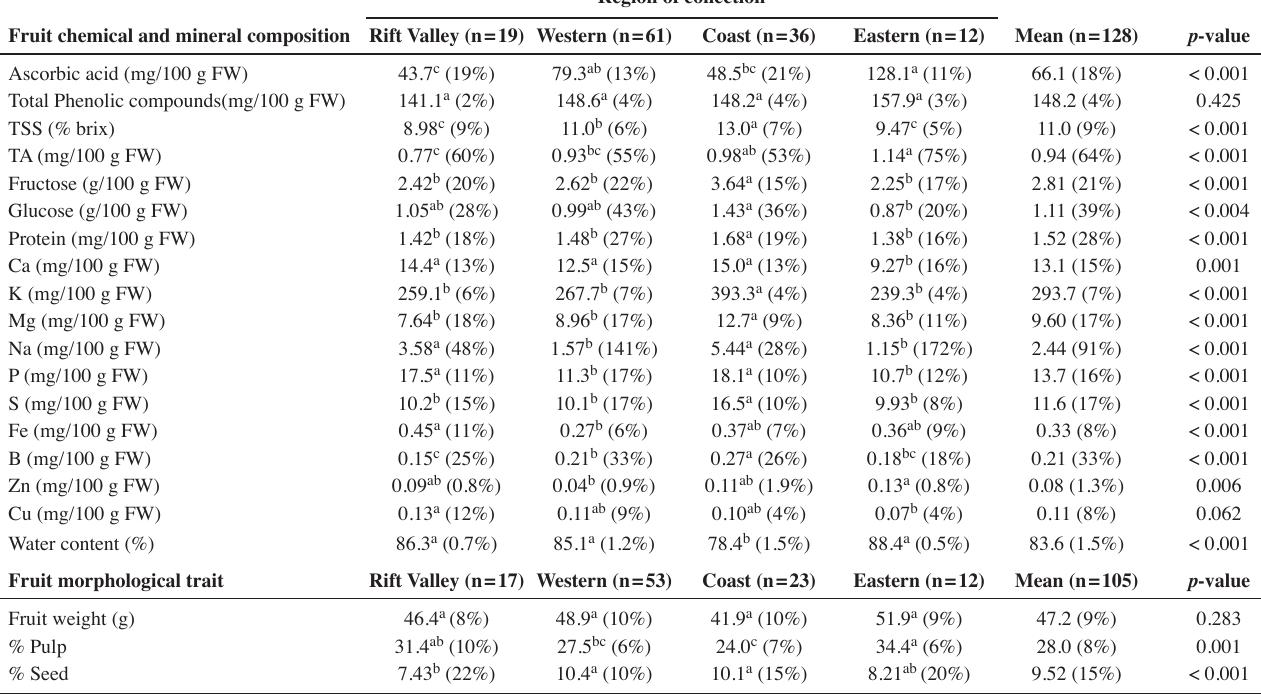
Tab. 1: Fruit chemical and mineral composition, and morphological traits of 128 guava accessions sampled from four regions of Kenya Region of collection Fruit chemical and mineral composition Rift Valley (n=19) Western